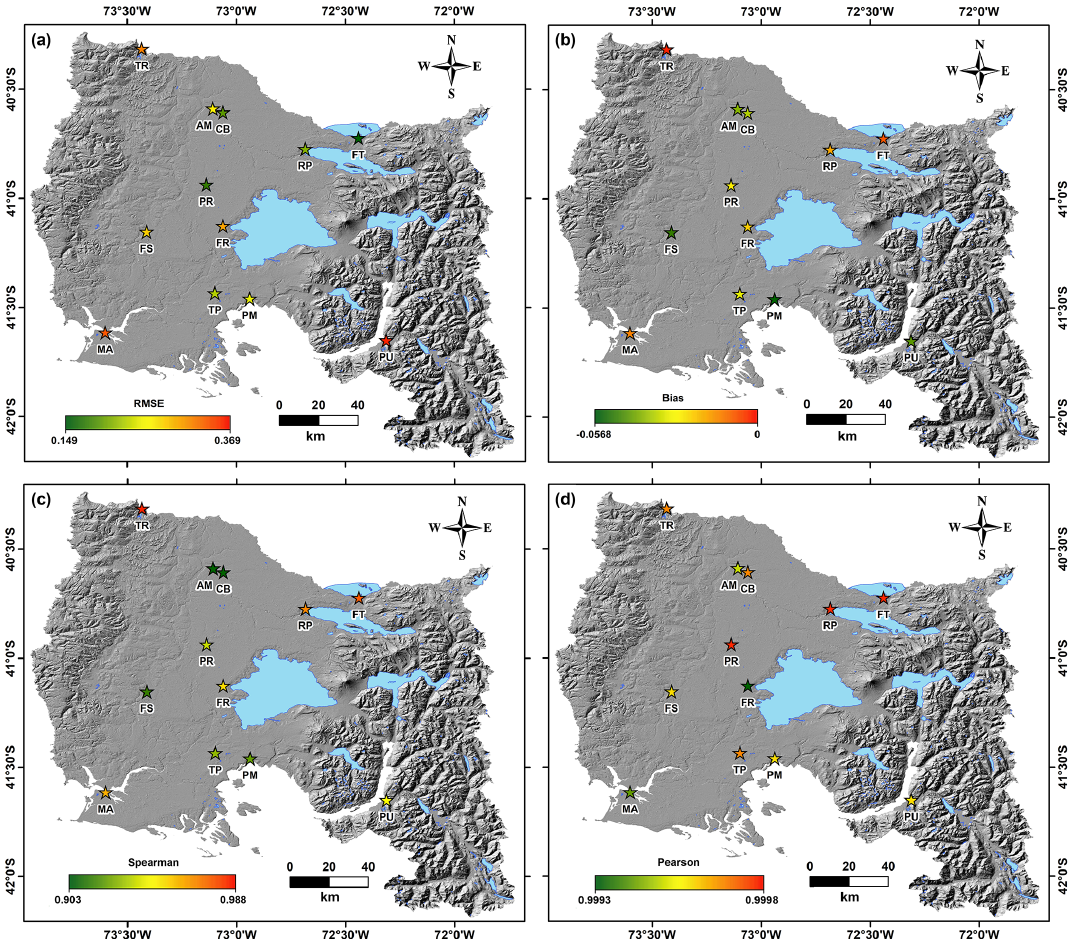
Figure 4. Statistical assessment of the model-corrected data versus weather station data using the best results (PP_M4a). (a) BIAS of the simulation in comparison with stations, (b) MAE of the simulation in comparison with stations, (c) RMSE of the simulation in comparison with stations, (d) Spearman correlation coefficient of the simulation in comparison with stations. Hillshade based on SRTM data. Table 3. Values of the estimators for the probit models. False-positive rate (FPR) and true-positive rate (TPR) were evaluated with a threshold of 95%. Intercept Daily